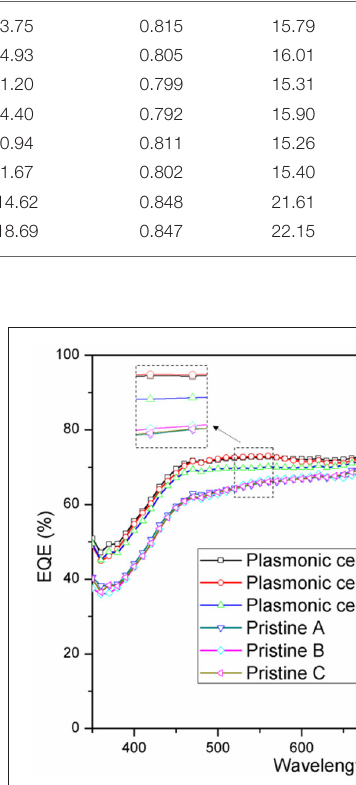
TABLE 1 | I-V characteristics of the single-junction (S-J)/three-junction (T-J) GaAs solar cells. Photovoltaic devices